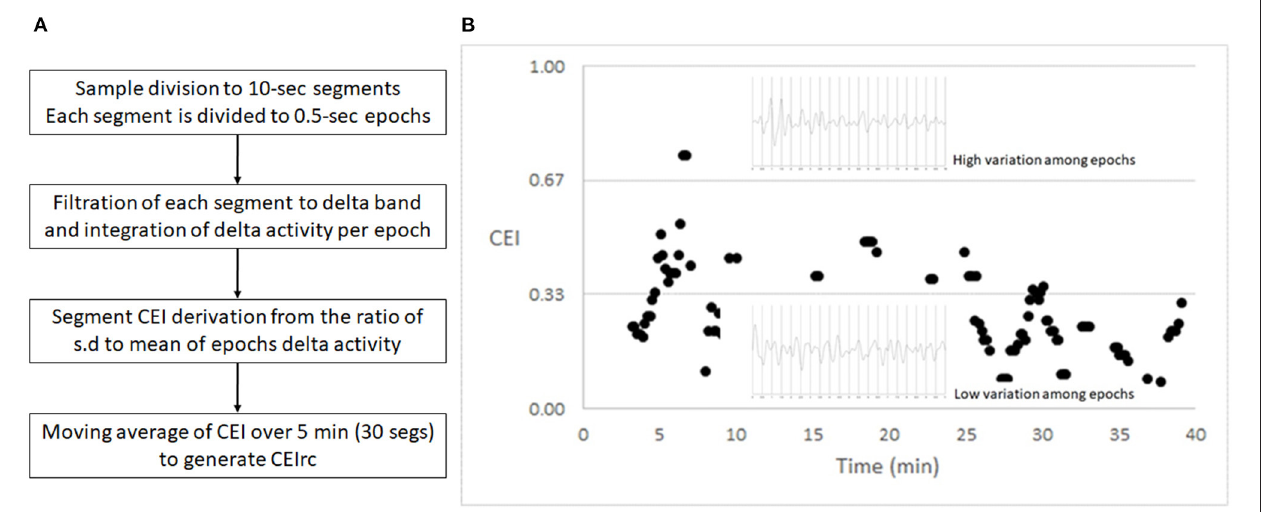
FIGURE 1 | CEI – an index of variability. (A) The flow of CEIrc computation. (B) A 40min sample of CEI values and two representative 10s EEG segments, filtered to the delta band pass. Each of the segments is divided to 20 half-second epochs. The upper segment shows greater variability among the power of the half-second epochs and therefore generates a higher CEI value. The lower segment shows lesser variability among the power of the half-second epochs and therefore generates a lower CEI value.